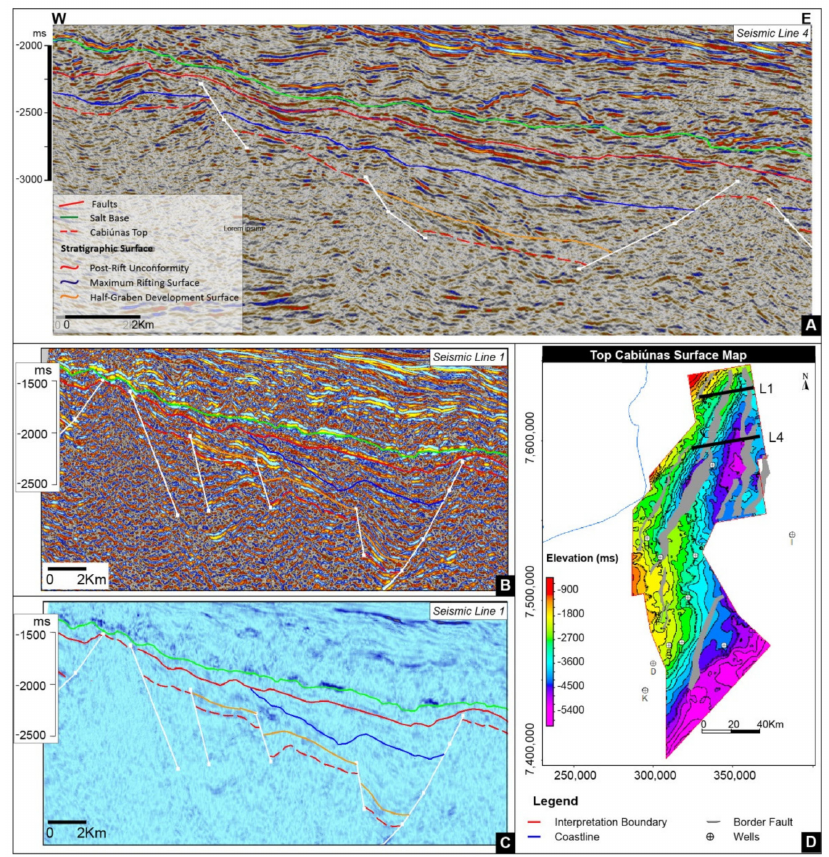
Figure 9. ( A ) Seismic pattern of the Cabi ú nas Fm. below the Cabi ú nas top surface (red dashed reflector), showing some scattered reflections indicative of deposition under tectonic activity, but without a clear definition for mapping. ( B ) Relative acoustic impedance attribute seismic pattern of the Cabi ú nas Fm. ( C ) Sweetness attribute seismic pattern of the Cabi ú nas Fm. ( D ) Map of the Cabi ú nas top